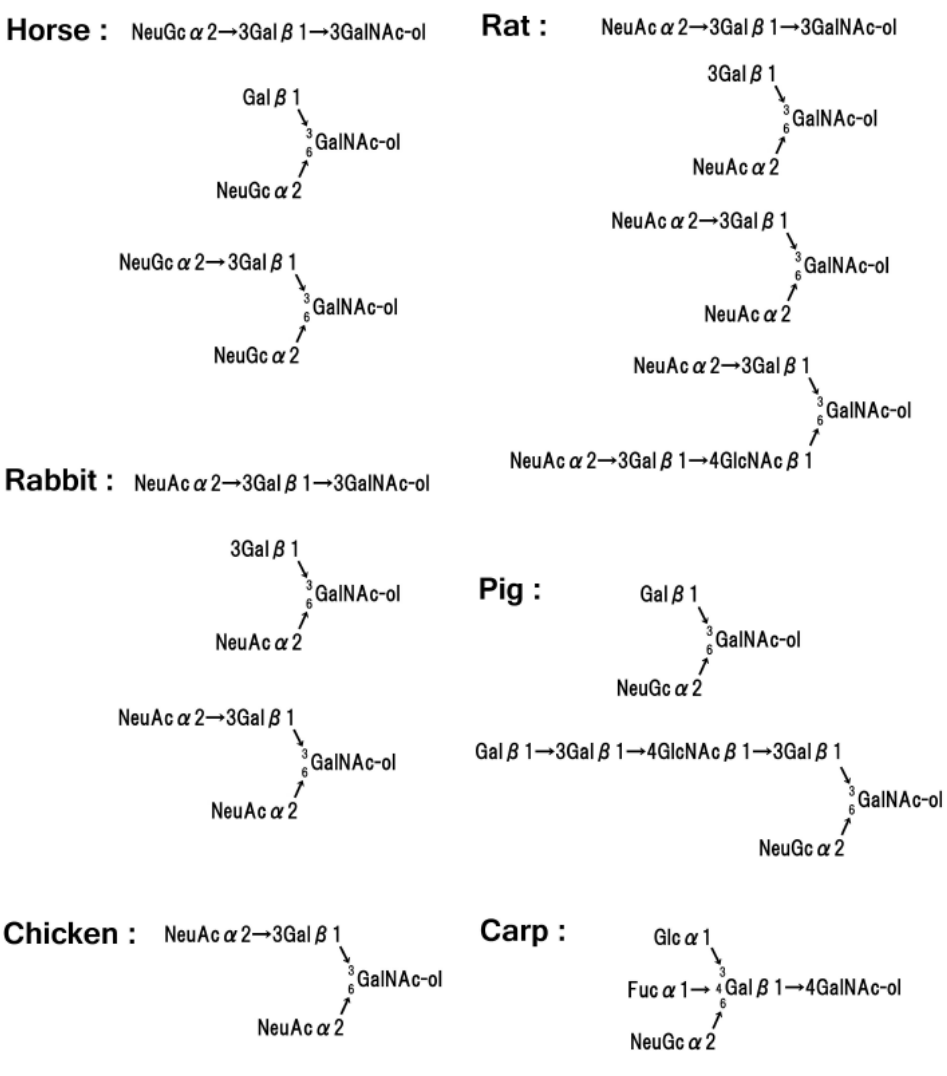
Figure 7. O-linked sialo-oligosaccharides of glycoproteins of mammalian, avian and teleost origins.